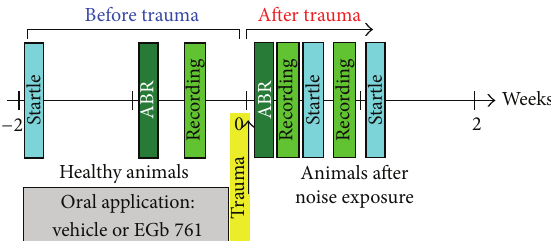
Figure 1: Timeline of the experiments. Two weeks prior to trauma (yellow bar) oral application of vehicle or EGb 761 was performed on a daily basis. Pretrauma measurements included behavioral startle responses (turquoise; hearing threshold and gap-noise tinnitus paradigms), ABR measurements (dark green), and electrophysio- logical recordings in auditory cortex (light green) both under anes- thesia. After the acoustic trauma the measurements were repeated within the first seven days after the